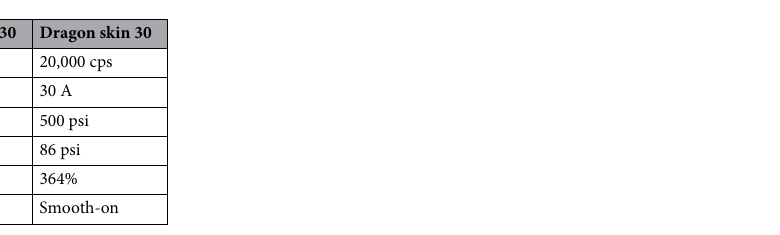
Table 2. Comparison between characteristics of Ecoflex 00-30 and Dragon skin